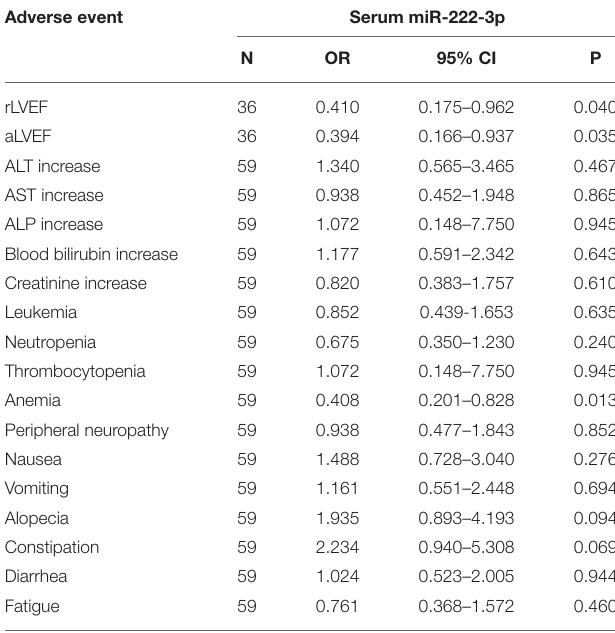
TABLE 4 | The association of serum miR-222-3p and adverse events. Adverse